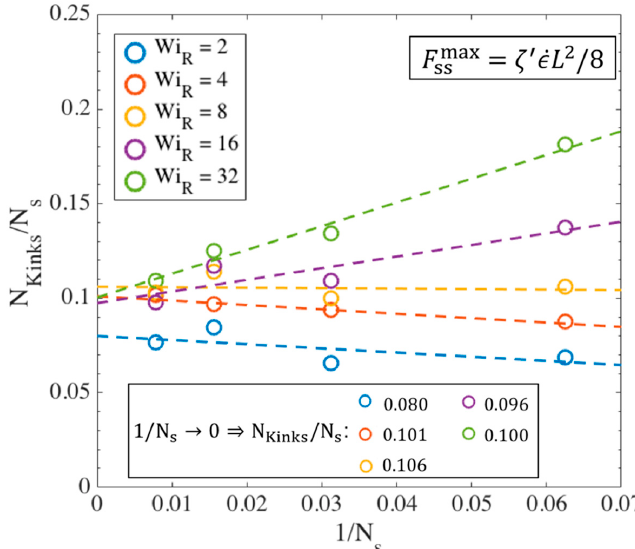
Figure 14. Number of kinks divided by the number of springs N s plotted against 1/ N s for different values of Wi R . The intercept with the y-axis is the asymptotic value of the ratio N Kinks / N s given in the legend for each Wi R .